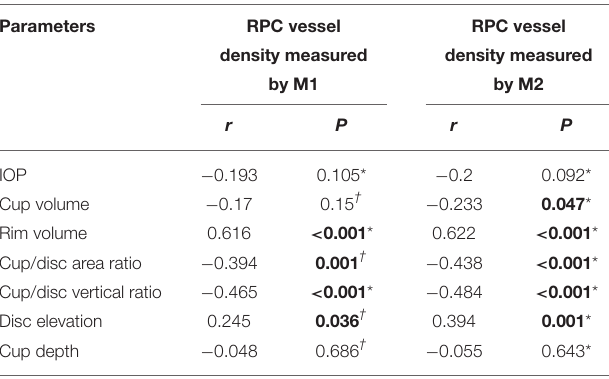
TABLE 3 | Correlations between radial peripapillary capillary vessel density measured by different methods and glaucomatous parameters.